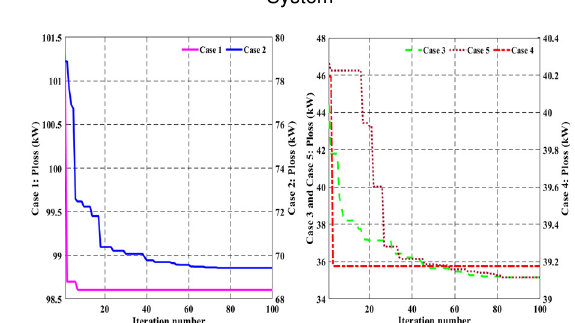
Fig. 12: Convergence Curve of Case 1 to Case 5 for IEEE